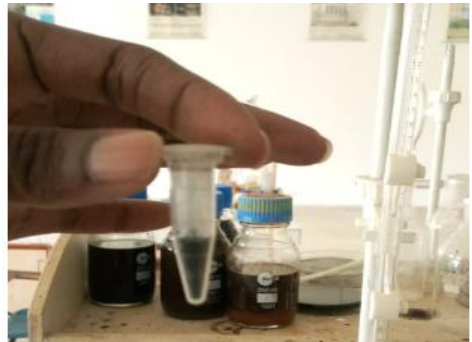
Fig. 2. Powdered form of Fe-NP after Figure 2: Powdered form of Fe-NP after drying